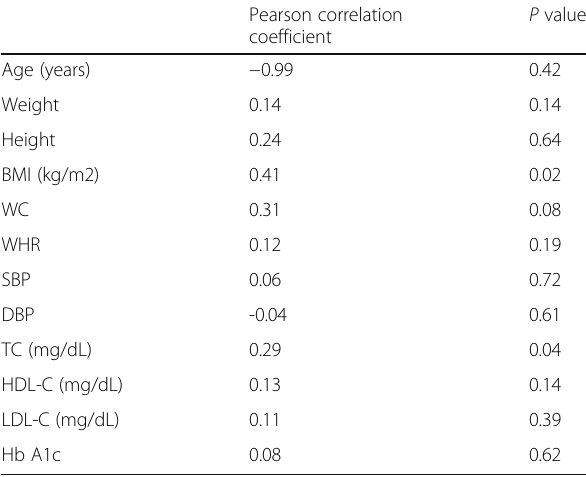
Table 6 Correlation analysis between hs-CRP and other parameters for the study group Pearson correlation